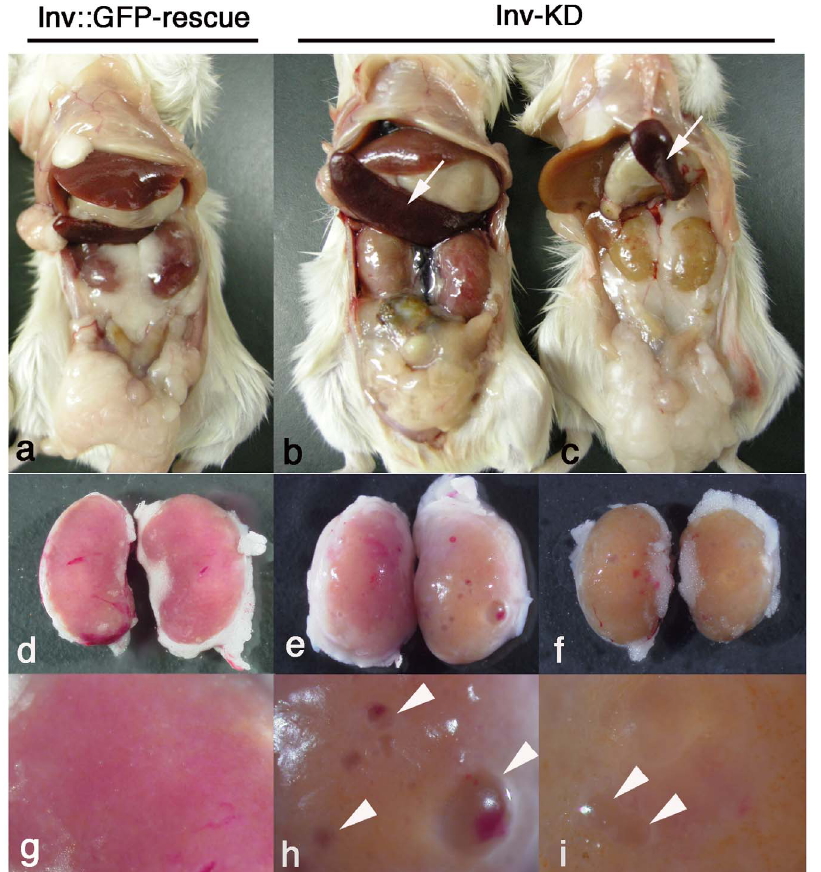
Figure 2. Anatomical analysis of adult Inv-KD mice. Anatomical analysis of pGtoR integrated adult (18 months old) Inv-KD mice (b and c) and control litter mate Inv::GFP-rescue mice (a). High magnification images of the kidney of (a–c) are shown in panels (d–f) and (g–i). Inv-KD mice developed fibrotic kidney with multiple cysts, but this was not observed in Inv::GFP-rescue mice. Highly developed multiple cysts were observed on the surface of Inv-KD mouse kidneys (h and i, arrowheads). Enlarged spleens were observed in adult Inv-KD mice (b and c, arrows).